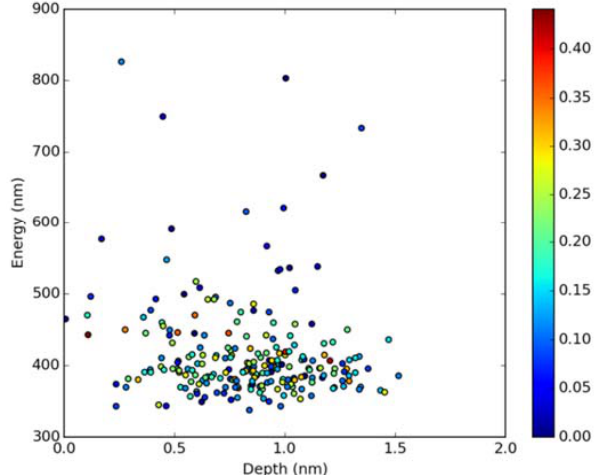
Molecules 2018 , 23 , x FOR PEER REVIEW Figure 8. Simulated (using electrostatic embedding) and experimental emission spectra of S 1 to S 0 transition of Laurdan in DOPC and DPPC bilayers.